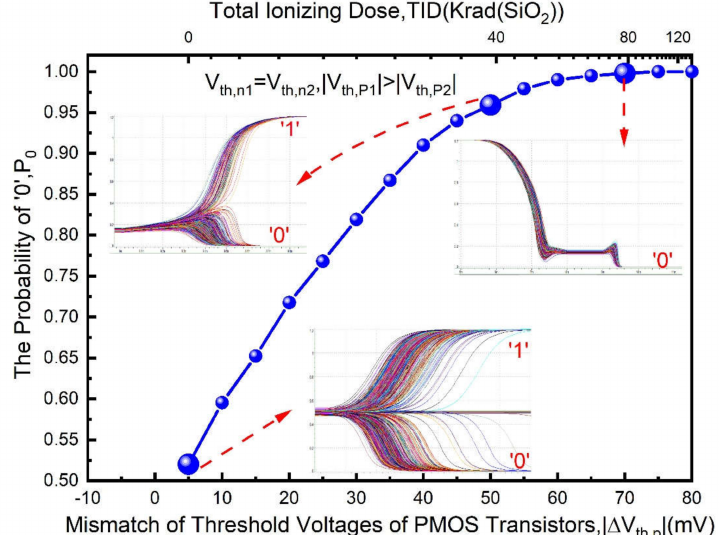
(cid:12) (cid:12) (cid:12) (cid:12) (cid:12) (cid:12) (cid:12) (cid:12) (cid:12) V th , p 1 (cid:12) > (cid:12) V th , p 2 (cid:12) ), it tends to be initialized to 0 as